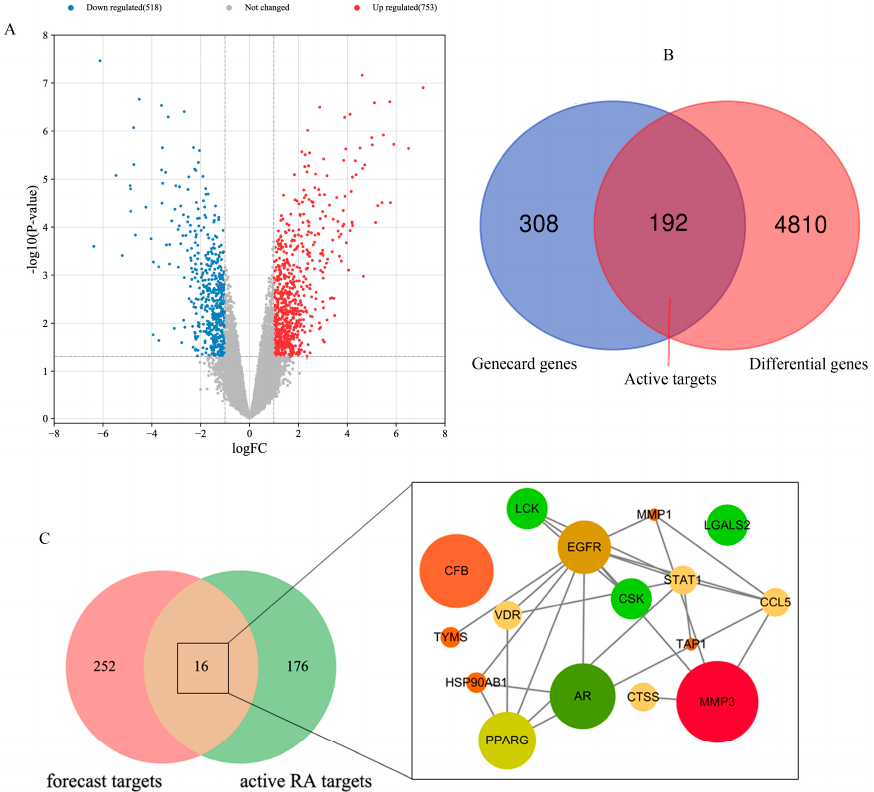
Figure 6. Analysis of RA genes and forecast targets of purpurin against RA, and functional characterization of potential targets of purpurin against RA. ( A ) Volcano-plot representation of differential gene expression. ( B ) Venn diagram depicting coincident genes of differential genes (top 500) and related genes from the GeneCard database. ( C ) Venn diagram depicting coincident genes of purpurin forecast targets and active RA genes.